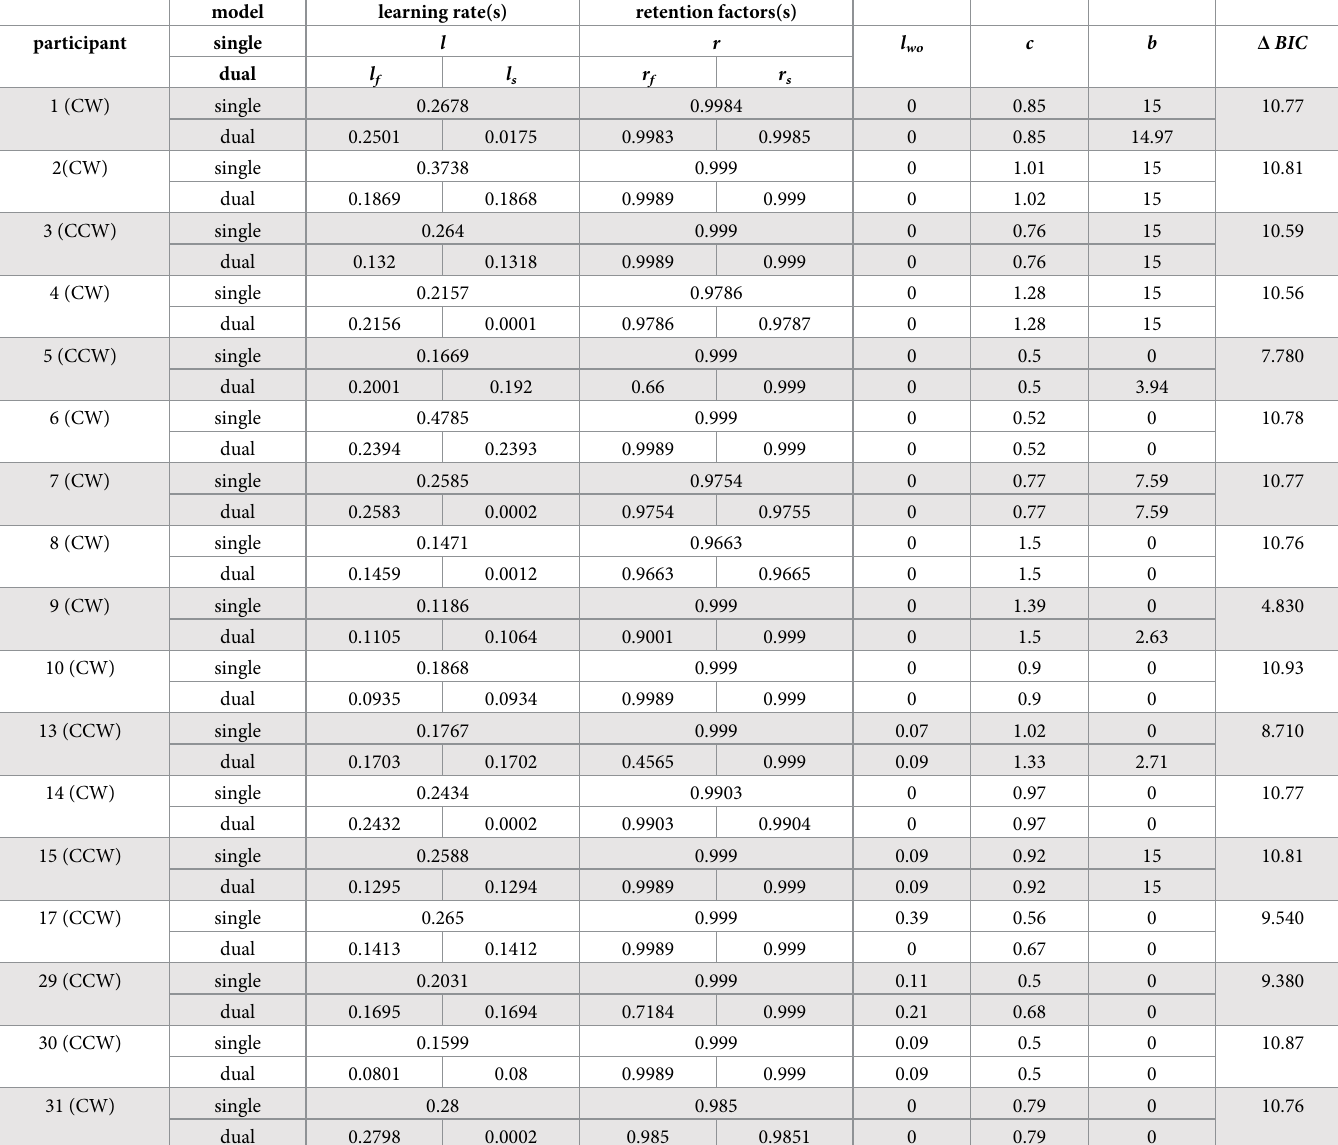
Table 1. Parameters of the single-rate and dual-rate model fit for individual participants of the experimental